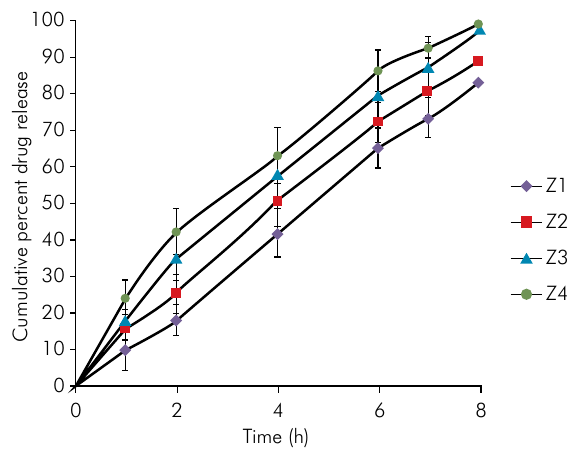
Figure 2. Comparison of the cumulative percentage of zolpidem released from different buccal films at various time points. In vitro drug release tests were carried out by placing film samples (2 × 1 cm) in a USP apparatus (paddle-over-disc) using simulated saliva as a dissolution medium. Values represent the mean of six trials ± standard deviation.